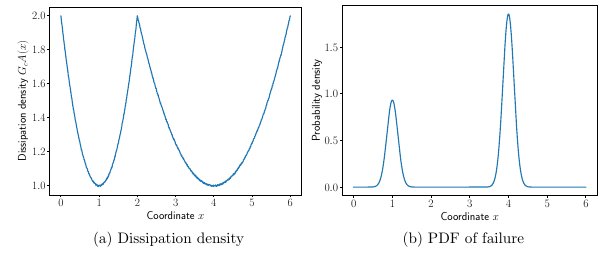
Fig. 30 Bar with quadratically varying fracture energy